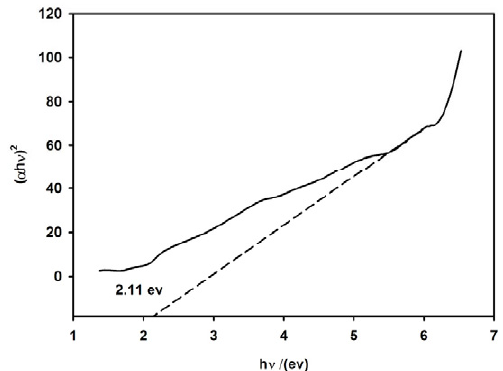
Fig. 5. UV–Vis absorption spectrum of iron oxide nanoparticles prepared by combination sol-gel auto- combustion with ultrasonic irradiation.